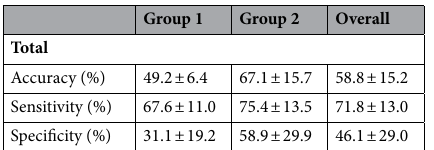
Table 1. Average assessment results for readers in each group.